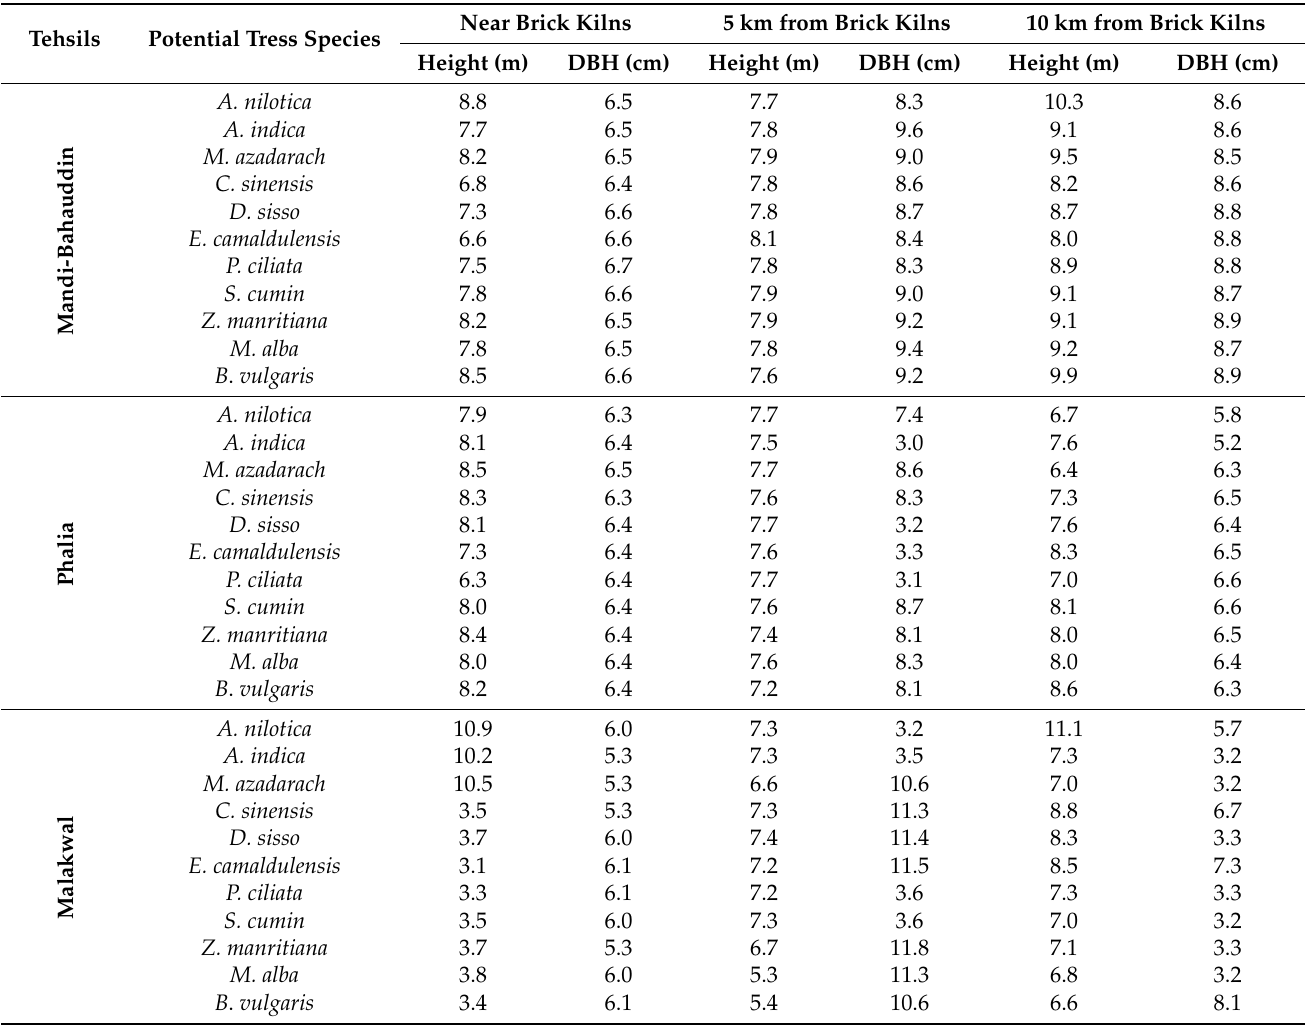
Table 2. Diameter at Breast Height (DBH) and Height of Potential Tree Species at Various